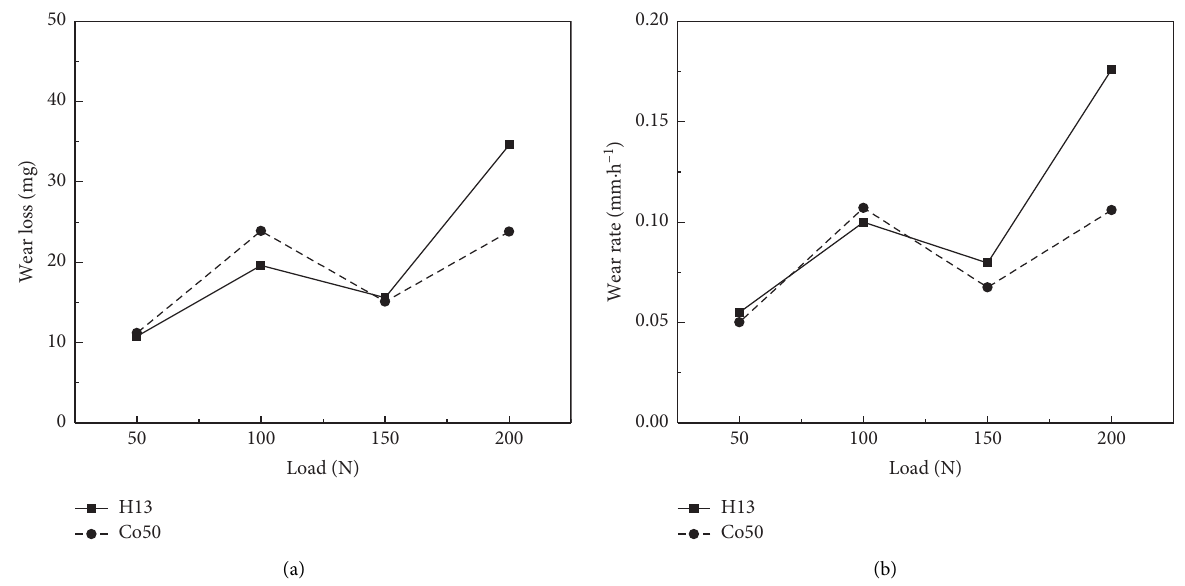
Figure 6: Effect of load on the (a) wear weight losses and (b) wear